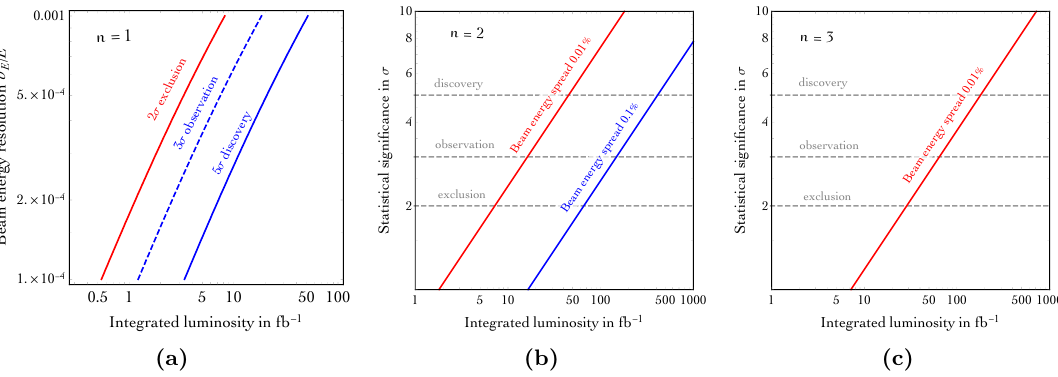
Figure 3. The integrated luminosity needed to see the n s 3 bound states with mass 2 M = 28 TeV of a Minimal DM 5-plet at a muon collider with s ≈ 4 M 2 is much smaller than the possible value, 90 / ab at σ = 10 − 3 . E /E